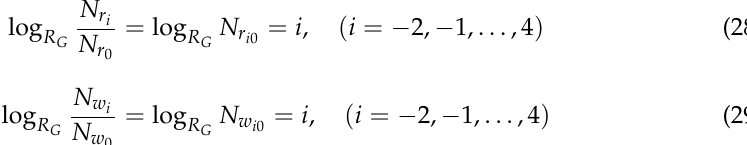
Table 13. Uncertainty estimations for Hybrid-mesh ( ∆ c = 5.88